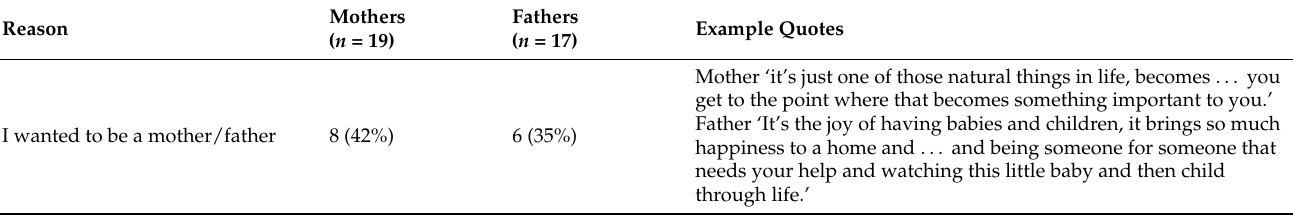
Table 3. Reasons for becoming a solo